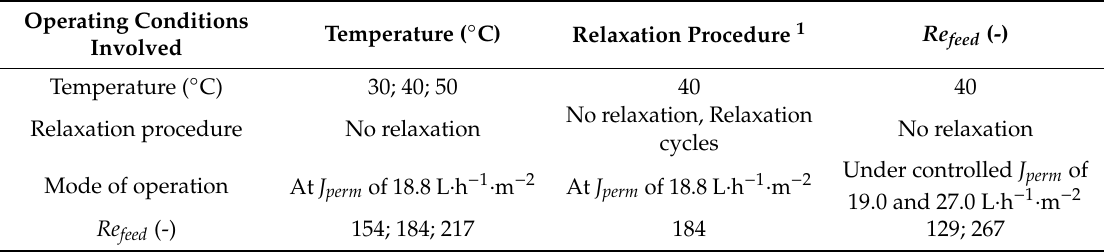
Operating conditions studied during the purification of the (diluted) raw material (arabinoxylans fraction) by